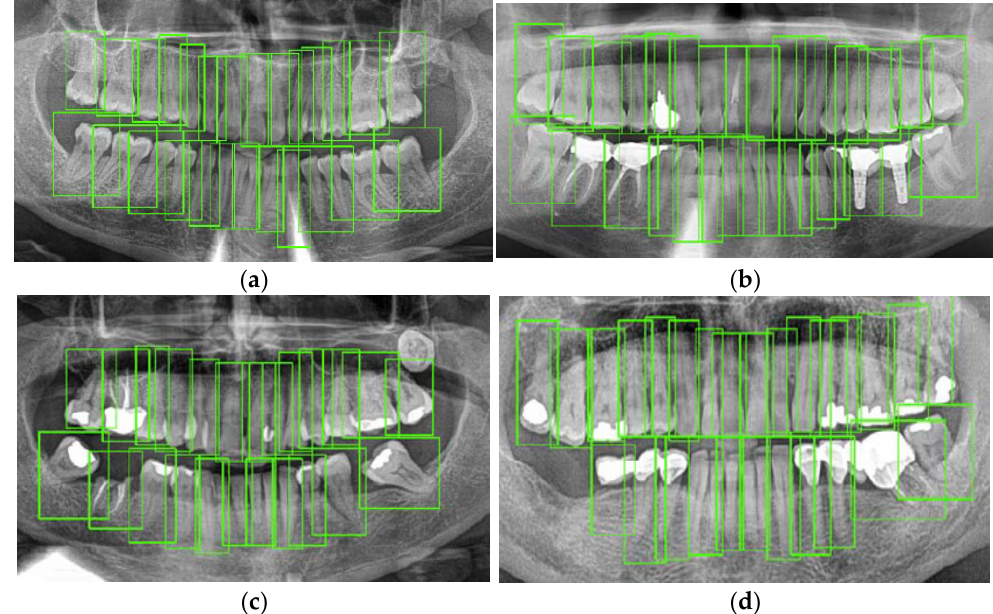
Figure 10. Model examples: ( a ) healthy patient; ( b ) dental implants and endodontic; ( c ) a tooth with only root; ( d ) prothesis.